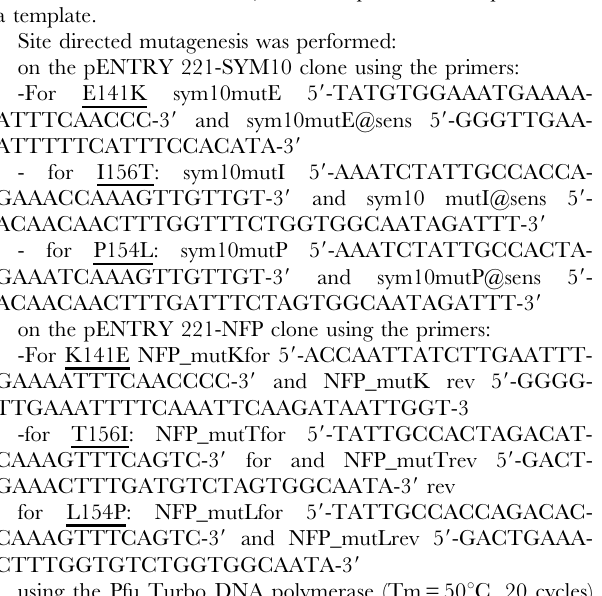
Figure S2 Comparison of NFP and SYM10 extracellular domains, and LysM2 with Medicago or Vicia